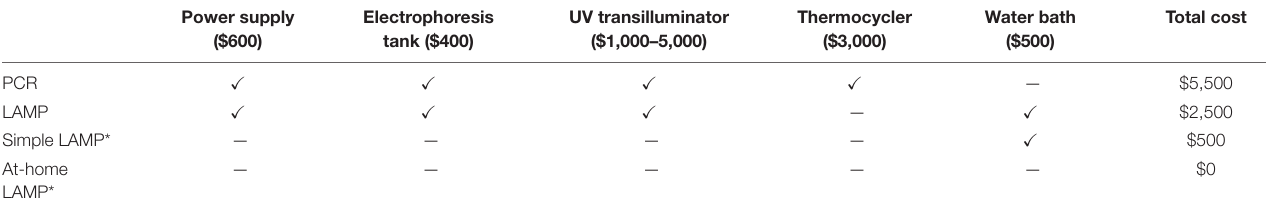
TABLE 2 | Materials required to set up LAMP and PCR.